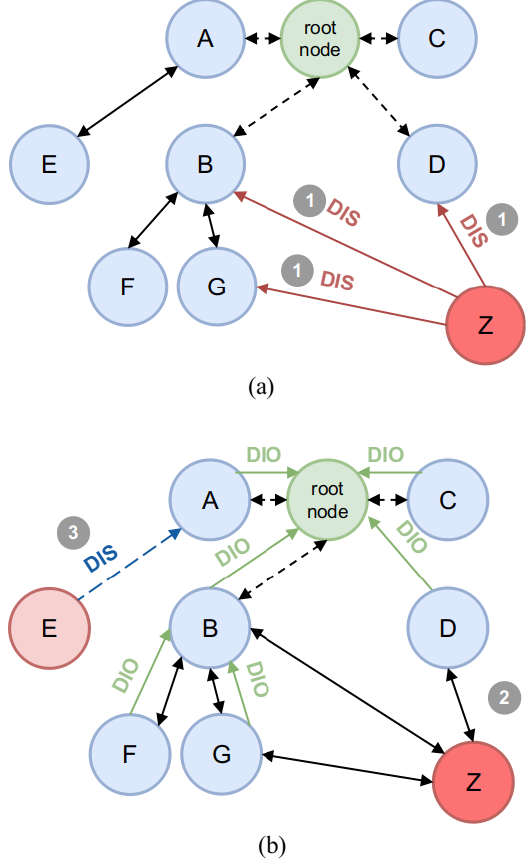
Figure 4. ( a ) Clone ID attack launching and ( b )